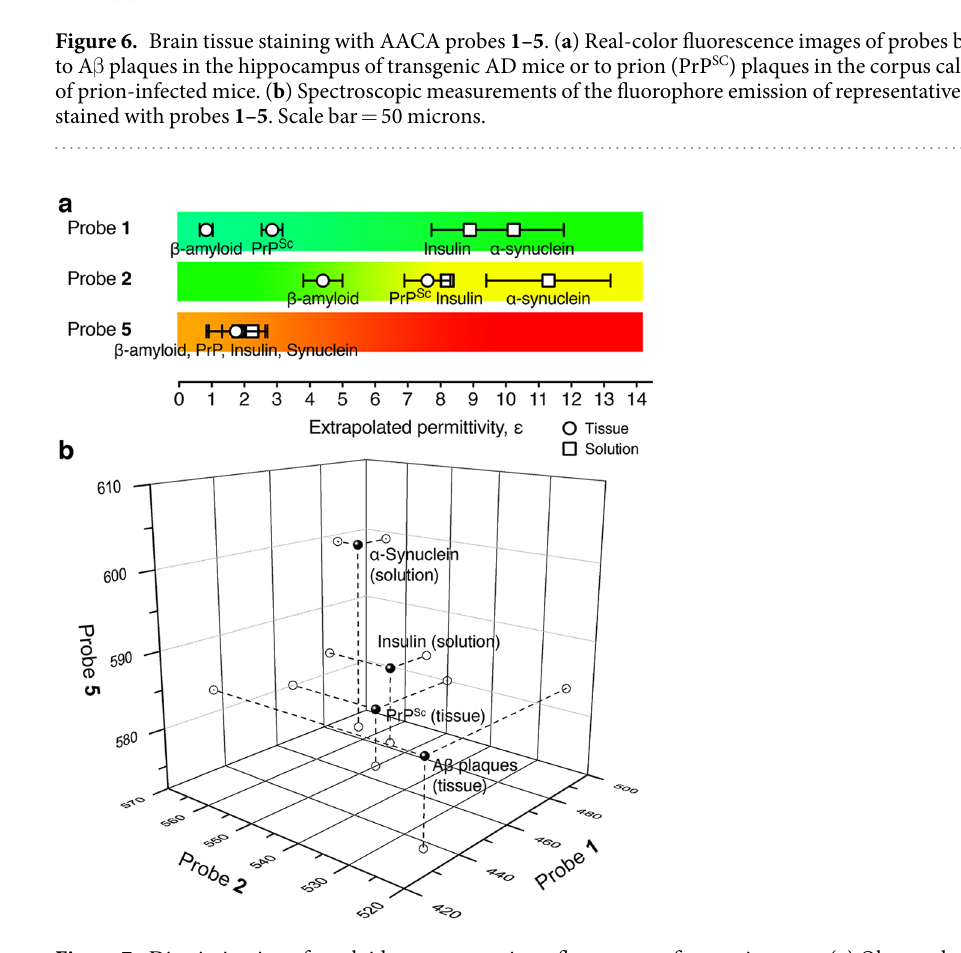
Figure 7. Discrimination of amyloid aggregates using a fluorescence fingerprint assay. ( a ) Observed color of fluorescence emission and corresponding extrapolated permittivities of molecular binding pockets on 4 different amyloids using AACA probes 1 , 2 , and 5 . ( b ) A three-dimensional fluorescence fingerprint analysis showing distinct 3 dimensional spectroscopic signatures (black spheres) for each protein aggregate using all 3 probes. The axes labels represent fluorescence emission wavelength in